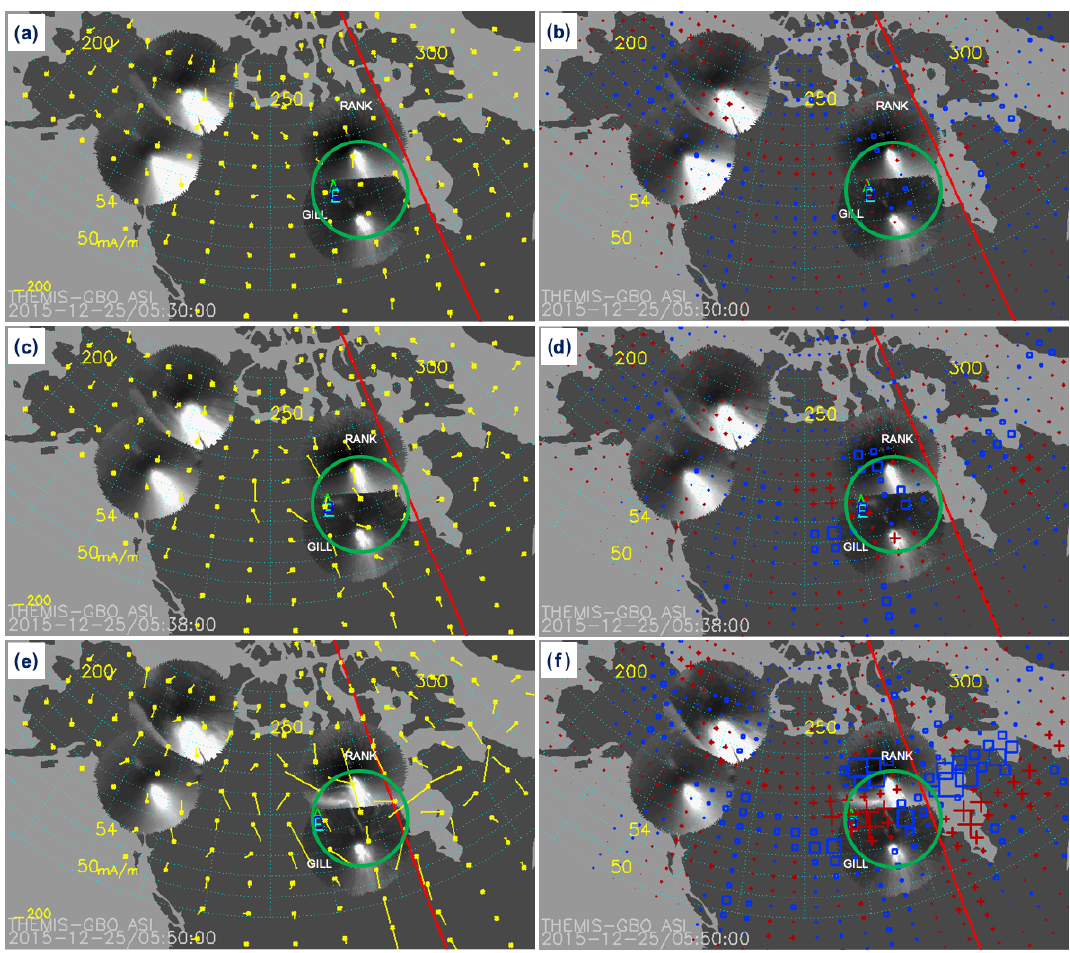
Figure 6. The derived equivalent ionospheric currents and current amplitudes plotted over a sequence of ASI mosaics for fast flow burst Case 1 on 25 December 2015. The caption of Fig. 2 applies.